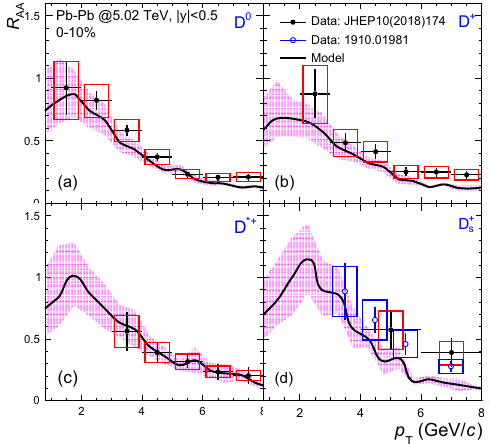
Fig. 10 Comparison of non-prompt (dashed blue curve) and prompt D 0 (solid black curve) R AA calculations as a function of p T with the measured values (point [56]), in the central 0–10% Pb–Pb collisions at √ s NN = 5 . 02 TeV. See legend and text for details